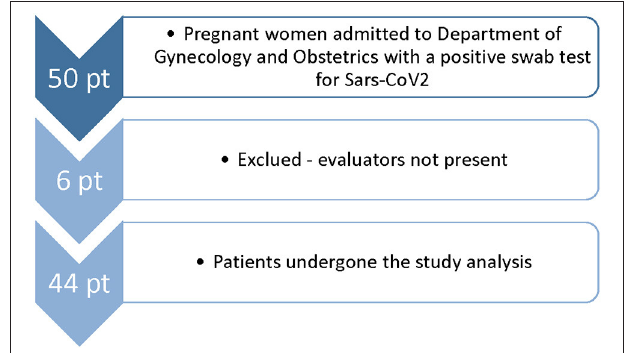
FIGURE 2 | Flowchart of enrollment of COVID-19 pregnant women in University Hospital of Udine from October 31, 2020 to March 31,